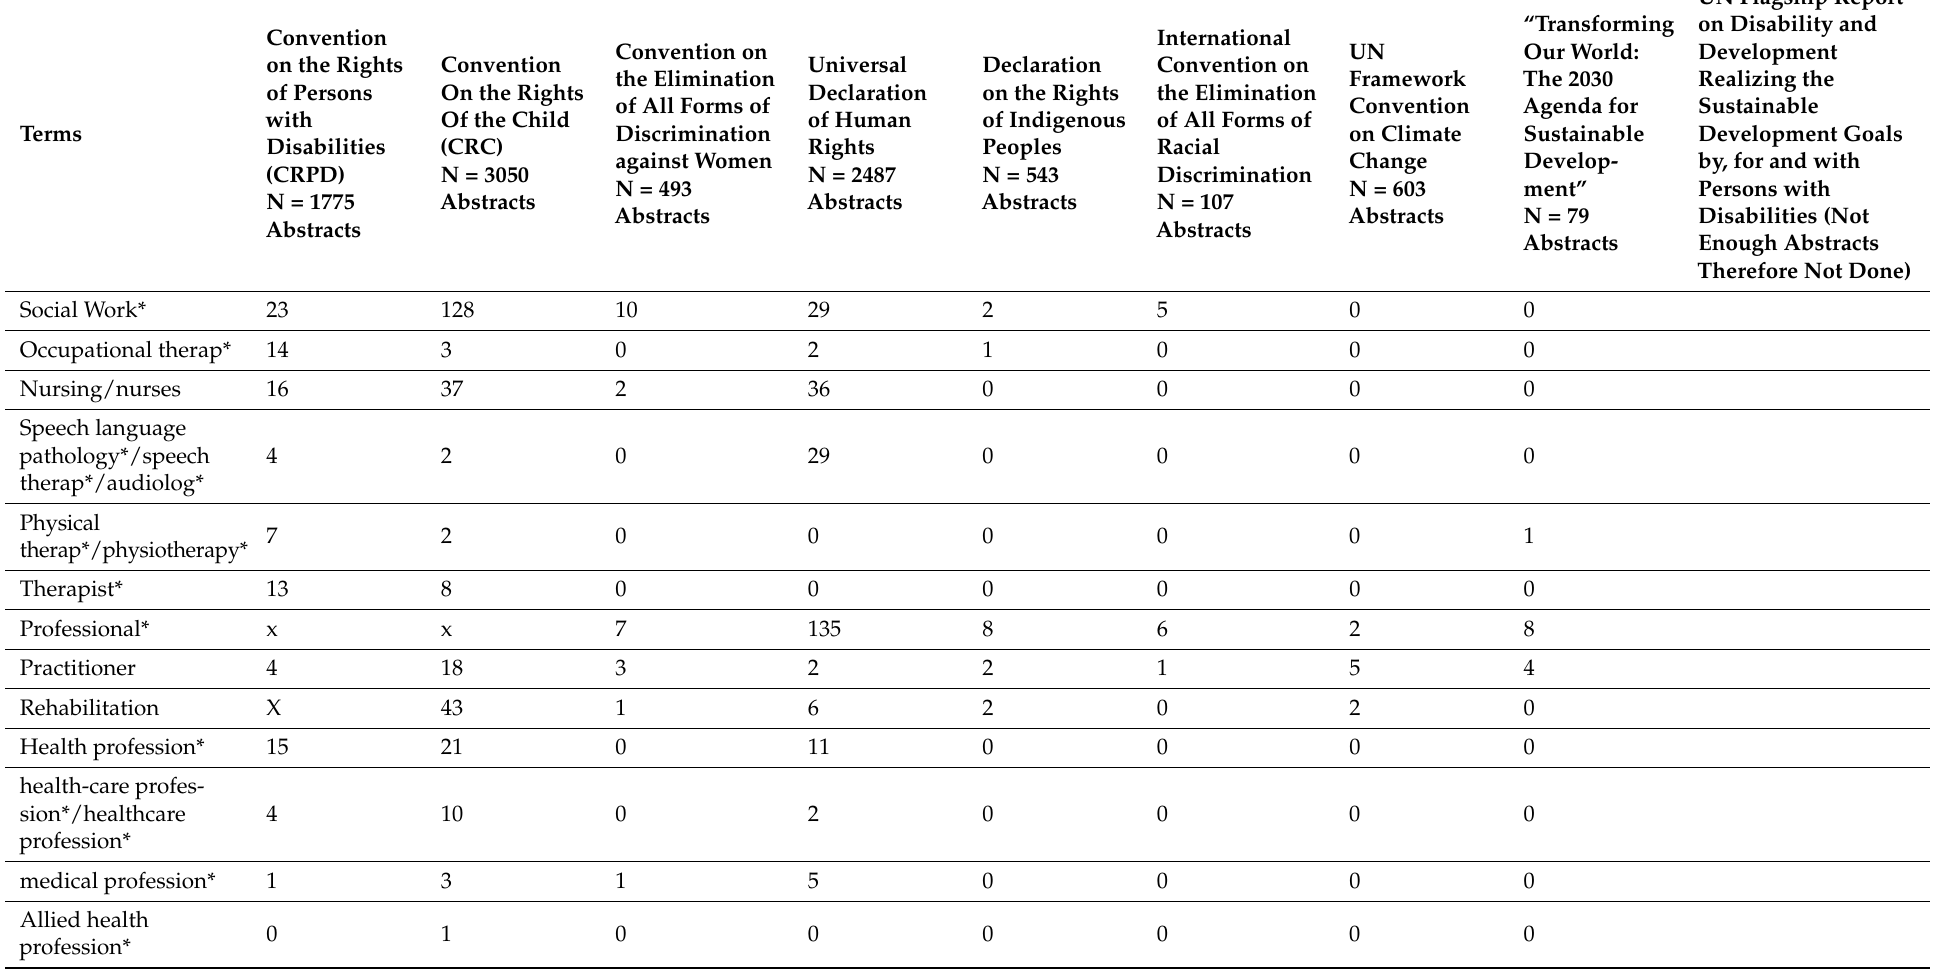
Table 21. Hitcounts of abstracts mentioning health